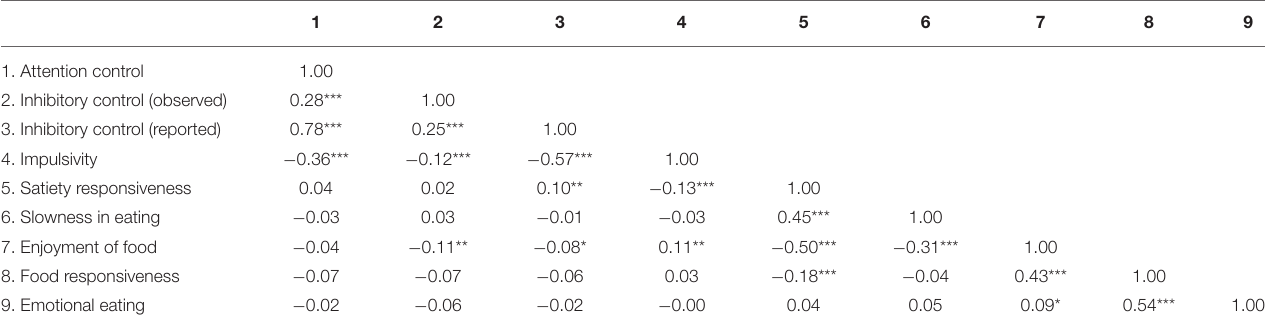
TABLE 1 | Inter-correlations between measures of behavioral self-regulation (BSR) and appetite self-regulation